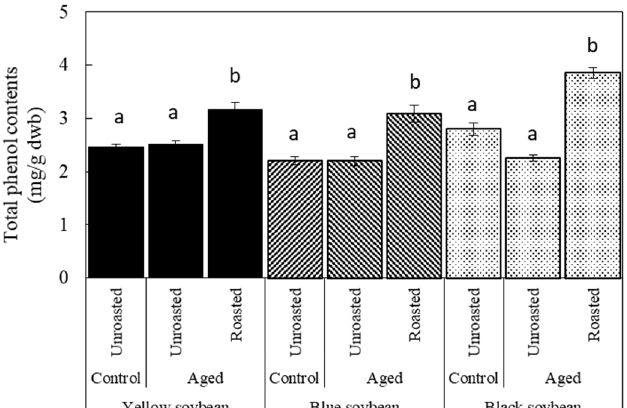
Figure 5. Total phenol contents of soybeans affected by storage and roasting. Storage condition: Control were stored at 4 °C/80% RH for 60 days; Aged beans were stored at 30 °C/75% RH for 60 days. Roasting condition was 190 °C for 20 min. Significant differences within the same bean are indicated by lowercase letters a, b, and c. p < 0.05. n = 3.